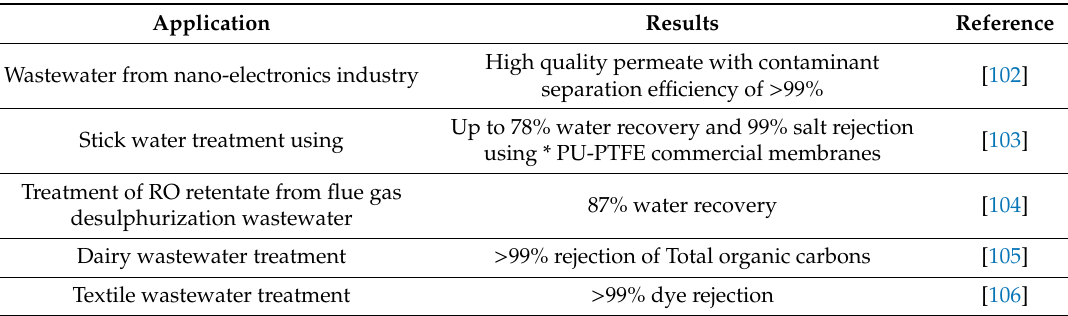
Table 6. Some application of MD in wastewater